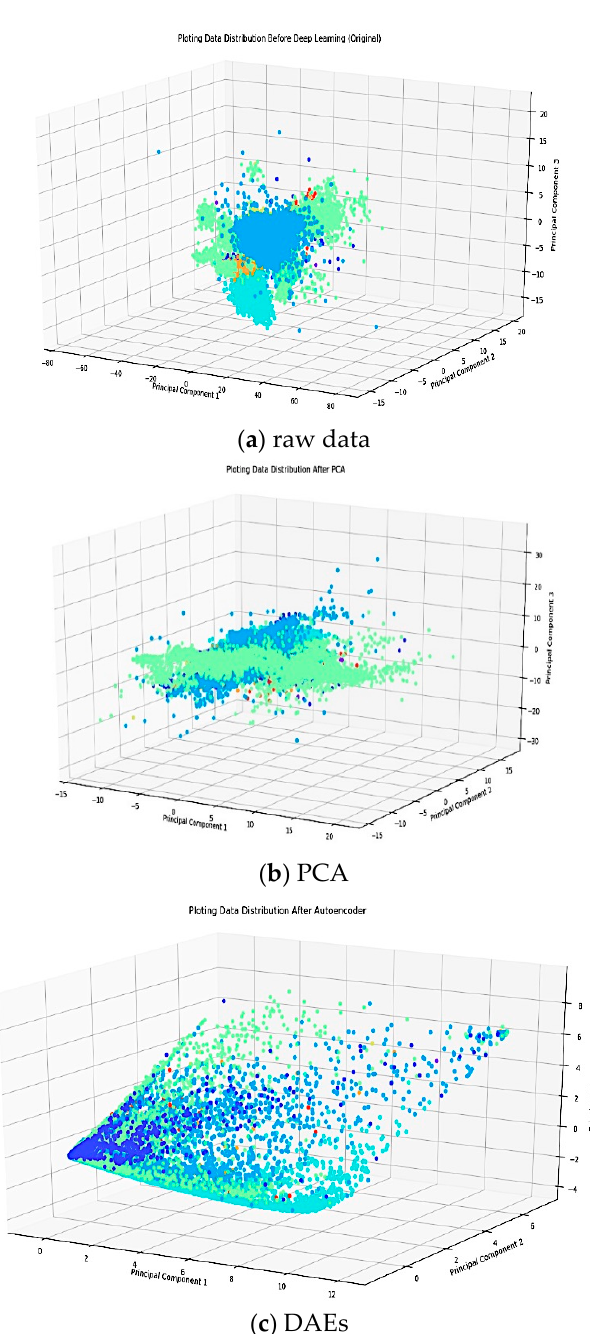
Figure 4. Data distribution plots in three conditions; raw data, PCA, and DAEs.